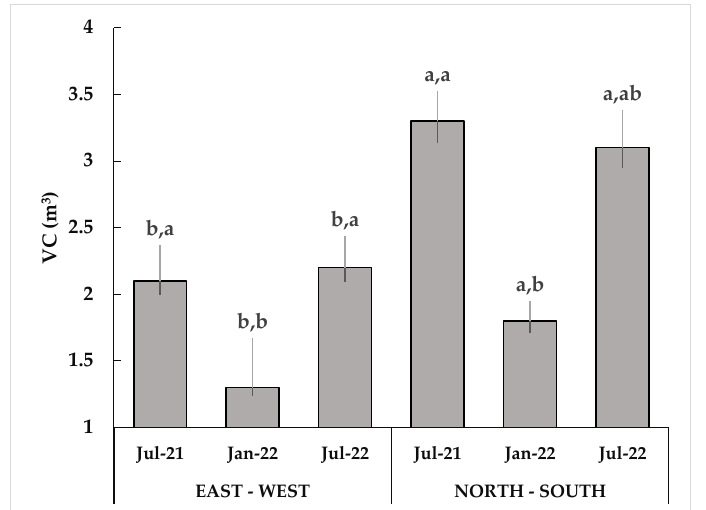
Figure 5. Canopy volume (CV; m 3 ) values in E – W and N – S orientations of a SHD almond orchard. First letters denote statistical differences between different row orientations; second letters denote statistical differences among different moments of observations ( p = 0.05; SNK test).